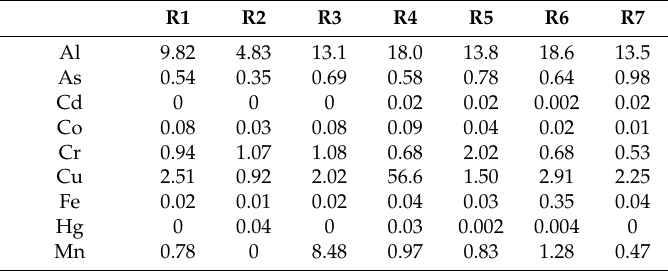
Table 4. Trace element and BTEX levels ( µ g/L) in water samples of the 2018-campaign (R1–R7 symbols are described on Figure